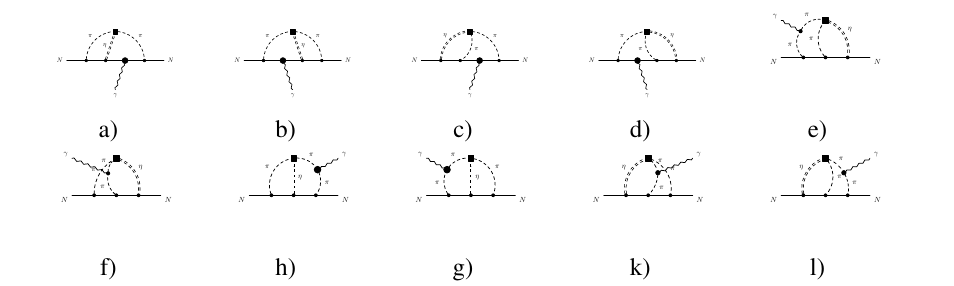
Figure 1. Diagrams describing the nEDM in the framework of PS interactions between mesons and baryons. The interaction with the external electromagnetic field occurs through the minimal electric coupling to charged baryon or meson fields. The solid square denotes the CP-violated ηπ + π − vertex.